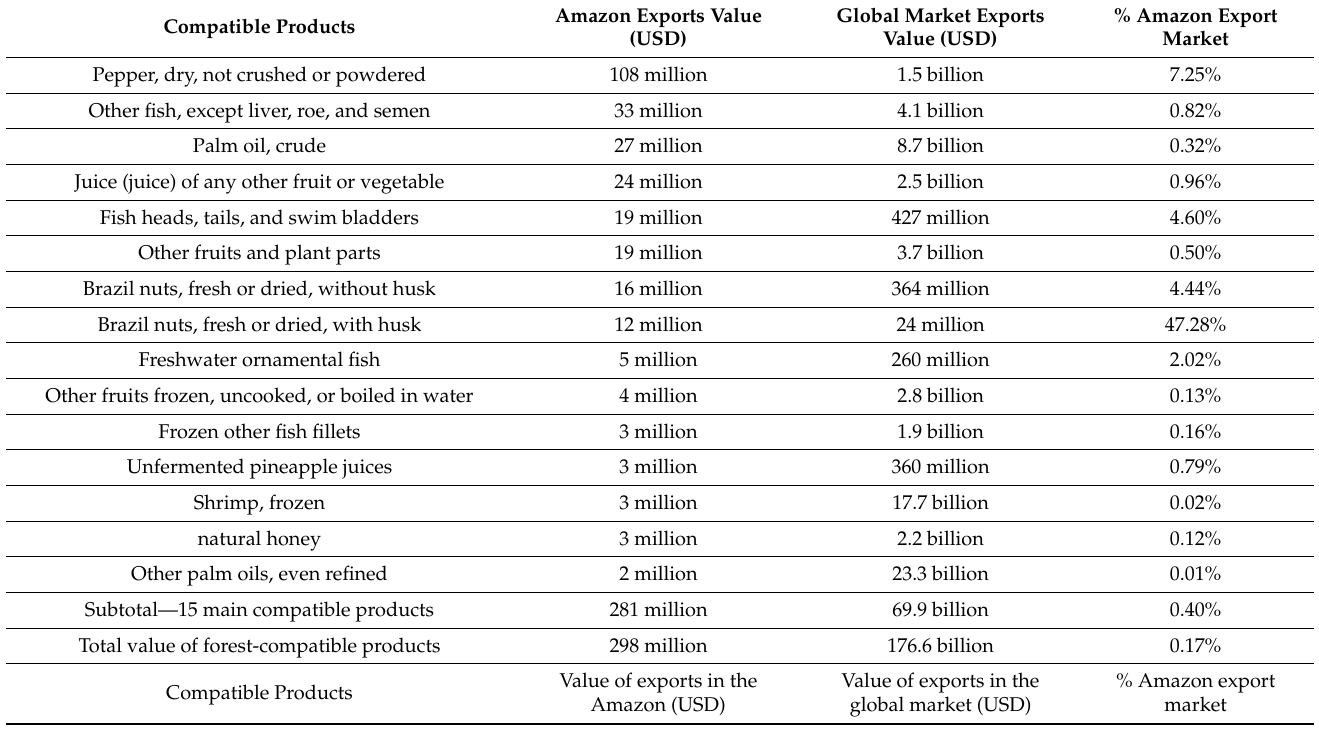
Table 8. Amazon forest products and their respective markets. Source: